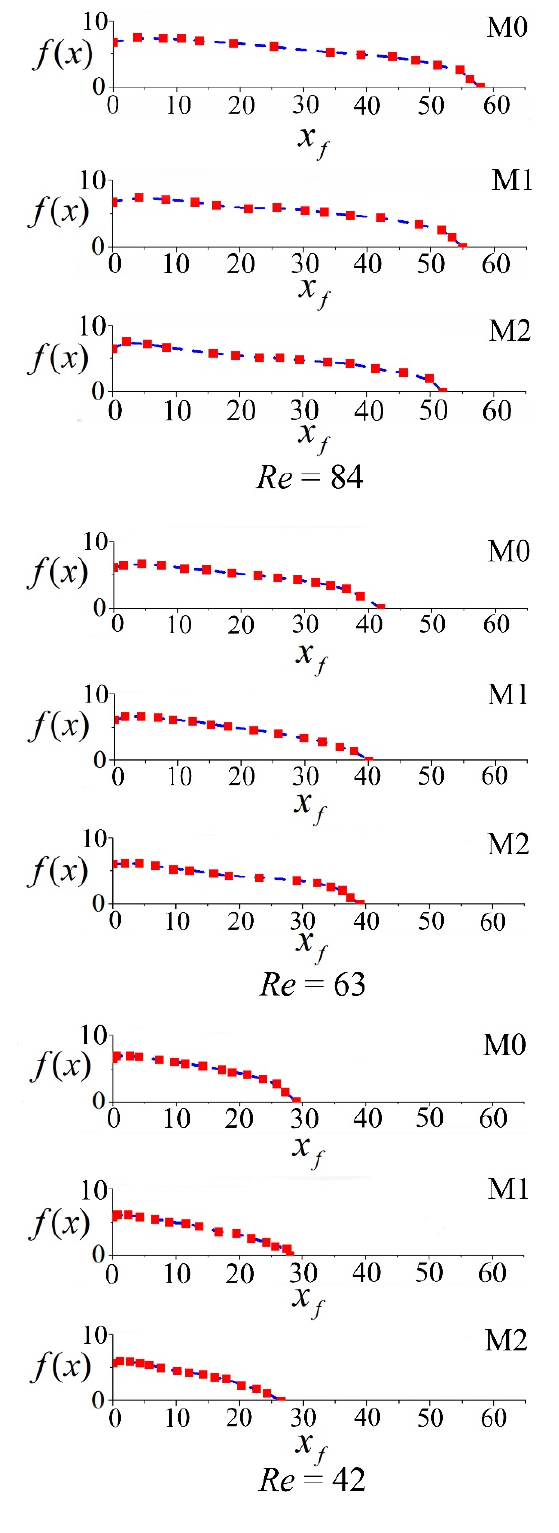
Figure 4. Profiles of diffusion flames under different scenarios of magnetic fields (red squares are selected points for curve fitting; blue lines are fitted curves about x f ) .